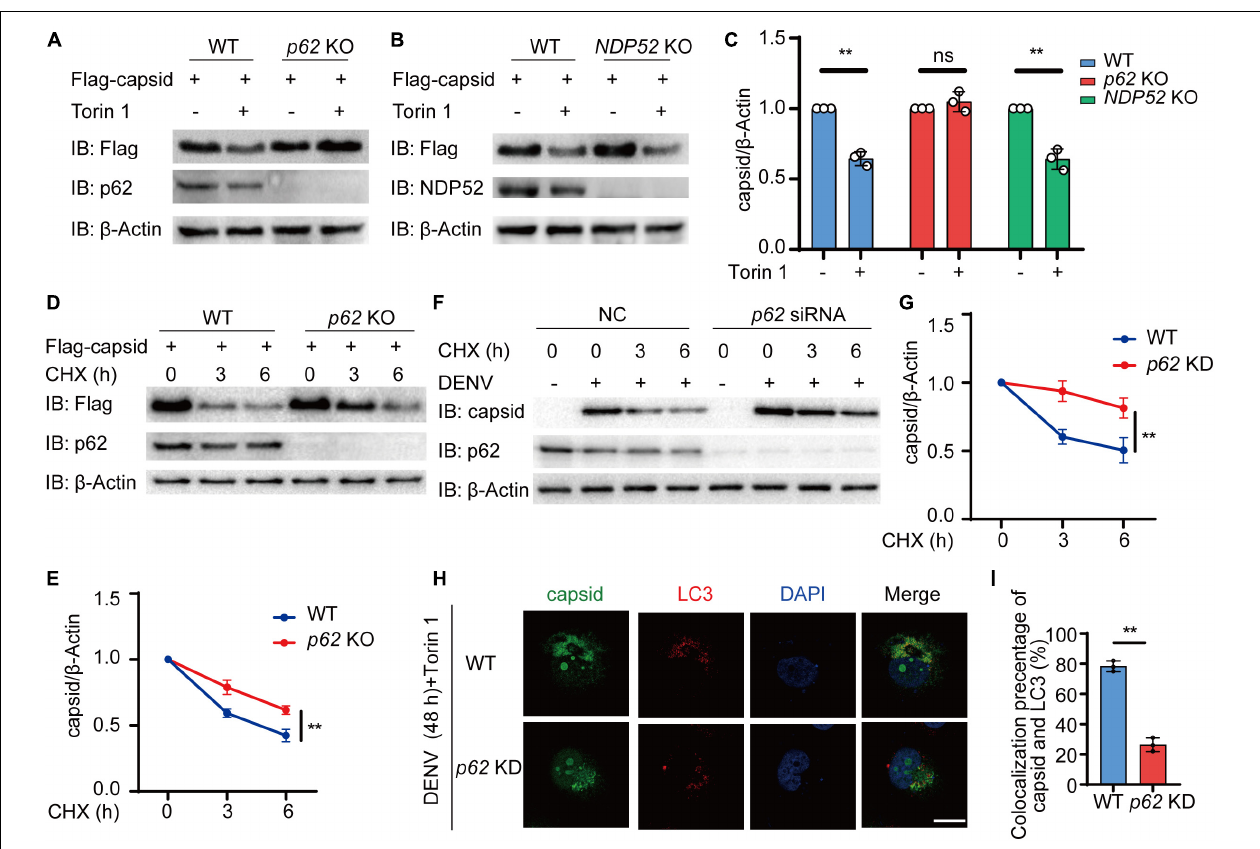
FIGURE 4 | p62 mediates the autophagic degradation of dengue virus (DENV) capsid protein. (A,B) Flag-C protein was transfected into WT, p62 KO (A), or NDP52 KO (B) cells, followed by 2 µ M Torin 1 treatments for 6 h. The cell lysates were immunoblotted with indicated antibodies. (C) The quantified levels of C protein from (A,B) were normalized to β -actin. (D) Flag-C protein was transfected into WT or p62 KO cells, followed by CHX (100 ng/ml) treatments for indicated time points. The cell lysates were subjected to immunoblot analysis with the indicated antibodies. (E) The quantified levels of C protein in (D) were normalized to β -actin. (F) Huh7 cells transfected with control (NC) or p62 -specific siRNA were infected with DENV (MOI = 0.5) for 48 h, followed by CHX (100 ng/ml) treatments for indicated time points. The cell lysates were immunoblotted with indicated antibodies. (G) The quantifiedlevels of C protein in (F) were normalized to β -actin. (H) Confocal microscopy of WT or p62 KD Huh7 cells infected with DENV (MOI = 0.5) for 24 h and Torin 1 (2 µ M) treatments for 6 h before harvesting, followed by labeling of C protein and LC3 with specific primary antibody and a CF568 goat anti-mouse IgG secondary antibody (red) and Alexa Fluor 488 conjugated anti-rabbit-IgG secondary antibody (green). Scale bar, 10 µ m. (I) Pearson’s correlation coefficients of DENV C protein and LC3 in (H) . Data represent replicate measurements in at least 10 cells from three independent experiments. Data in (C,E,G,I) are expressed as mean ± SEM of three independent experiments. ** p < 0.01, ns, not significant (two-tailed Student’s t -test). All the experiments are representatives of three independent biological experiments with similar